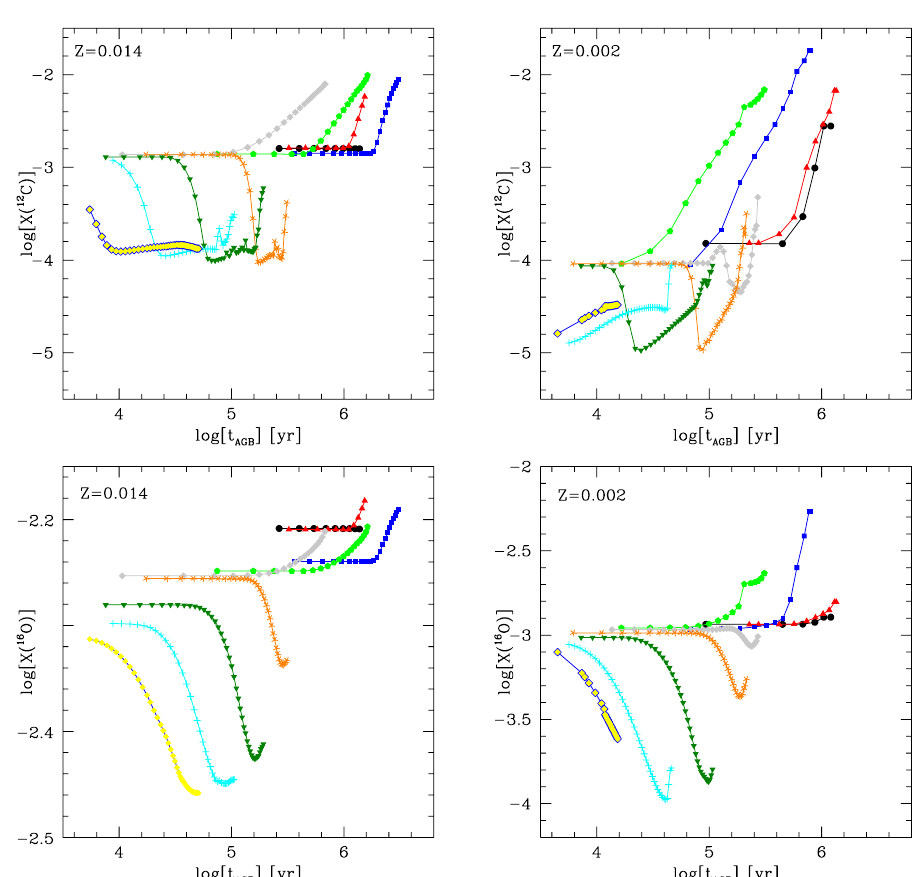
Figure 4. Time variation of the surface carbon ( top panels) and oxygen ( bottom panels) mass fractions of the same model stars reported in Figure 3. The same meaning of the different symbols was adopted. Both times and surface abunances are reported in logarythmic